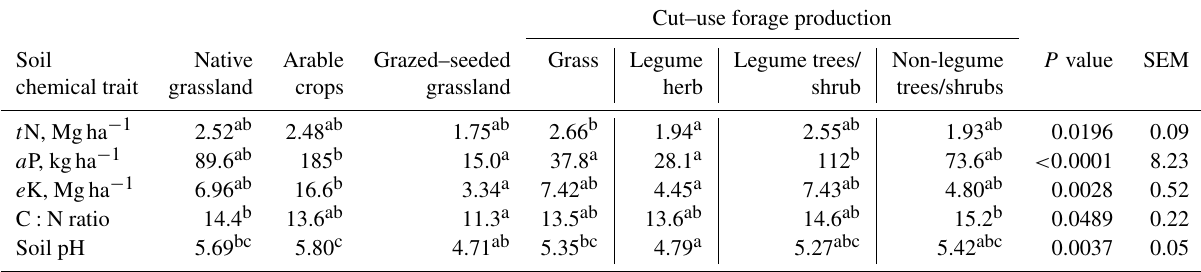
Table 2. Soil organic carbon, soil macronutrients and other chemical properties of soils under different long-term management. Cut–use forage production Soil Native Arable Grazed–seeded Grass Legume Legume trees/ Non-legume P value SEM chemical trait grassland crops grassland herb shrub trees/shrubs